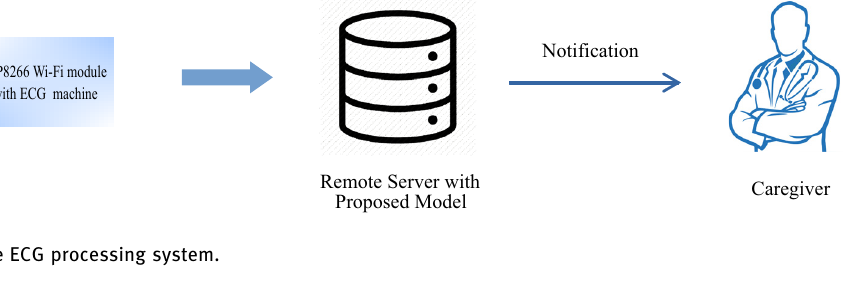
Figure 1: Remote ECG processing